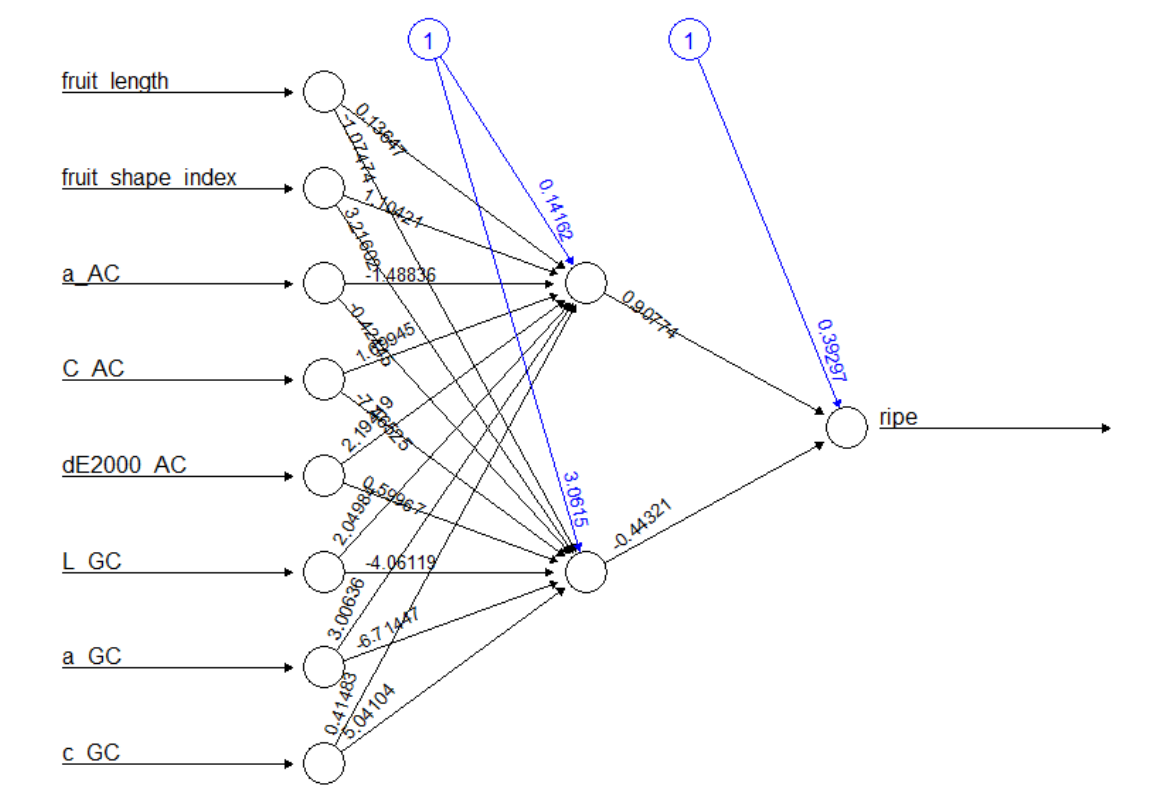
Figure 5. Representation of the ANN network with 8 input variables and 2 hidden layers with the output variable ripe . output variable ripe .